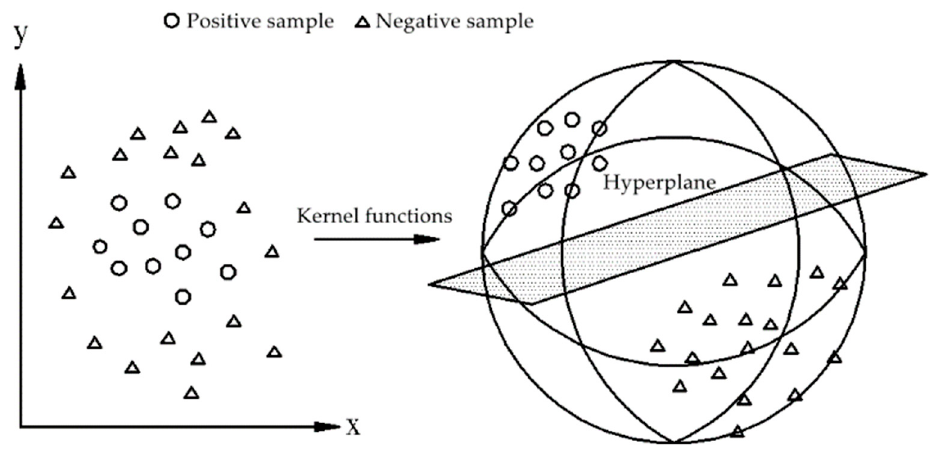
Figure 10. Mapping function of Gaussian kernel function.